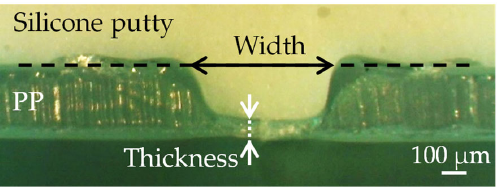
Figure 1. Cross ‐ section of a PP sample processed in the condition of 167 J/cm 2 . Figure 1. Cross-section of a PP sample processed in the condition of 167 J/cm 2